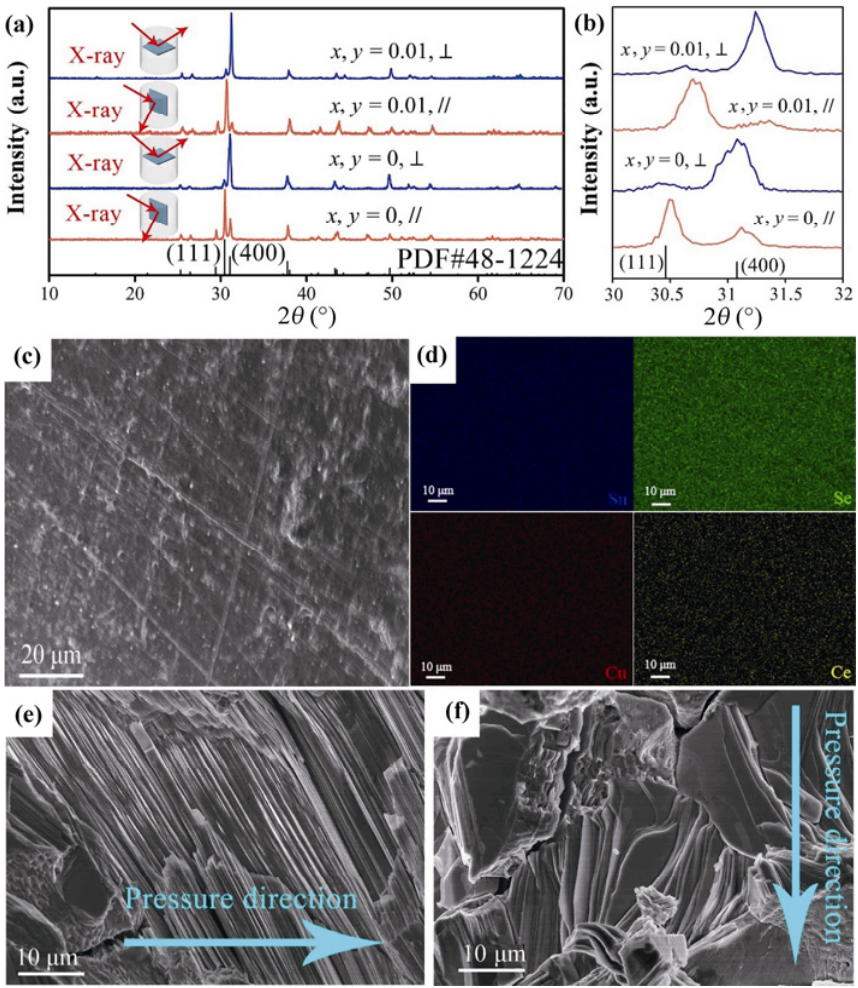
Fig. 7 (a) XRD patterns of sintered SnSe powders (both pure and Sn 0.98 Cu 0.01 Ce 0.01 Se) measured along both ⊥ (blue lines) and ∥ (orange lines) directions. (b) Magnified main XRD pattern peaks of (111) and (400) to see peak shift. (c) SEM image of polished surface taken from sintered Sn 0.98 Cu 0.01 Ce 0.01 Se. (d) EDS mapping results for (a). SEM micrographs of hot-pressed sample for Sn 0.98 Cu 0.01 Ce 0.01 Se with (e) perpendicular direction and (f) parallel